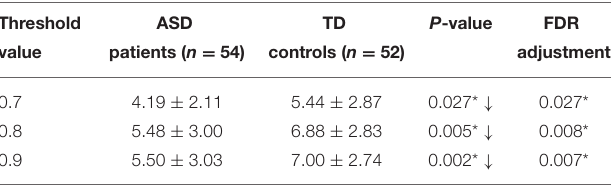
TABLE 1 | Statistically significant differences in the number of FC neural circuits (8–12) between the two